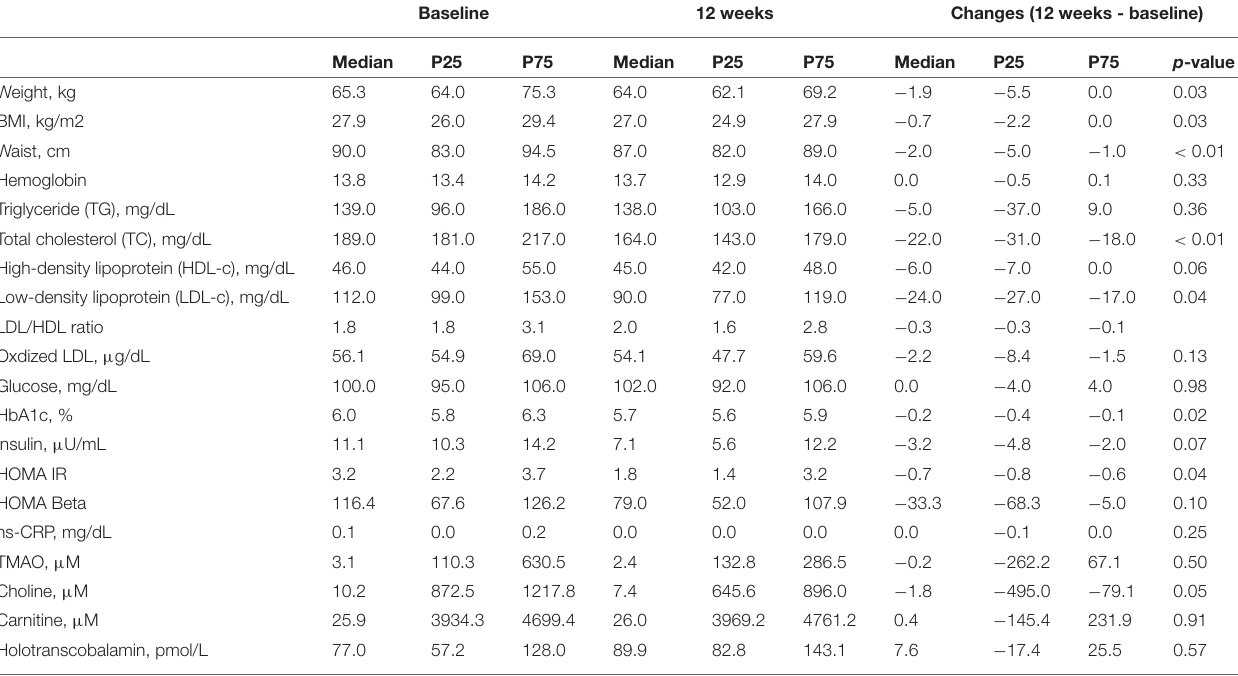
TABLE 4 | Nuclear magnetic resonance spectral analysis of GlycA and lipoprotein particles and size of the nine participants. Baseline 12 weeks